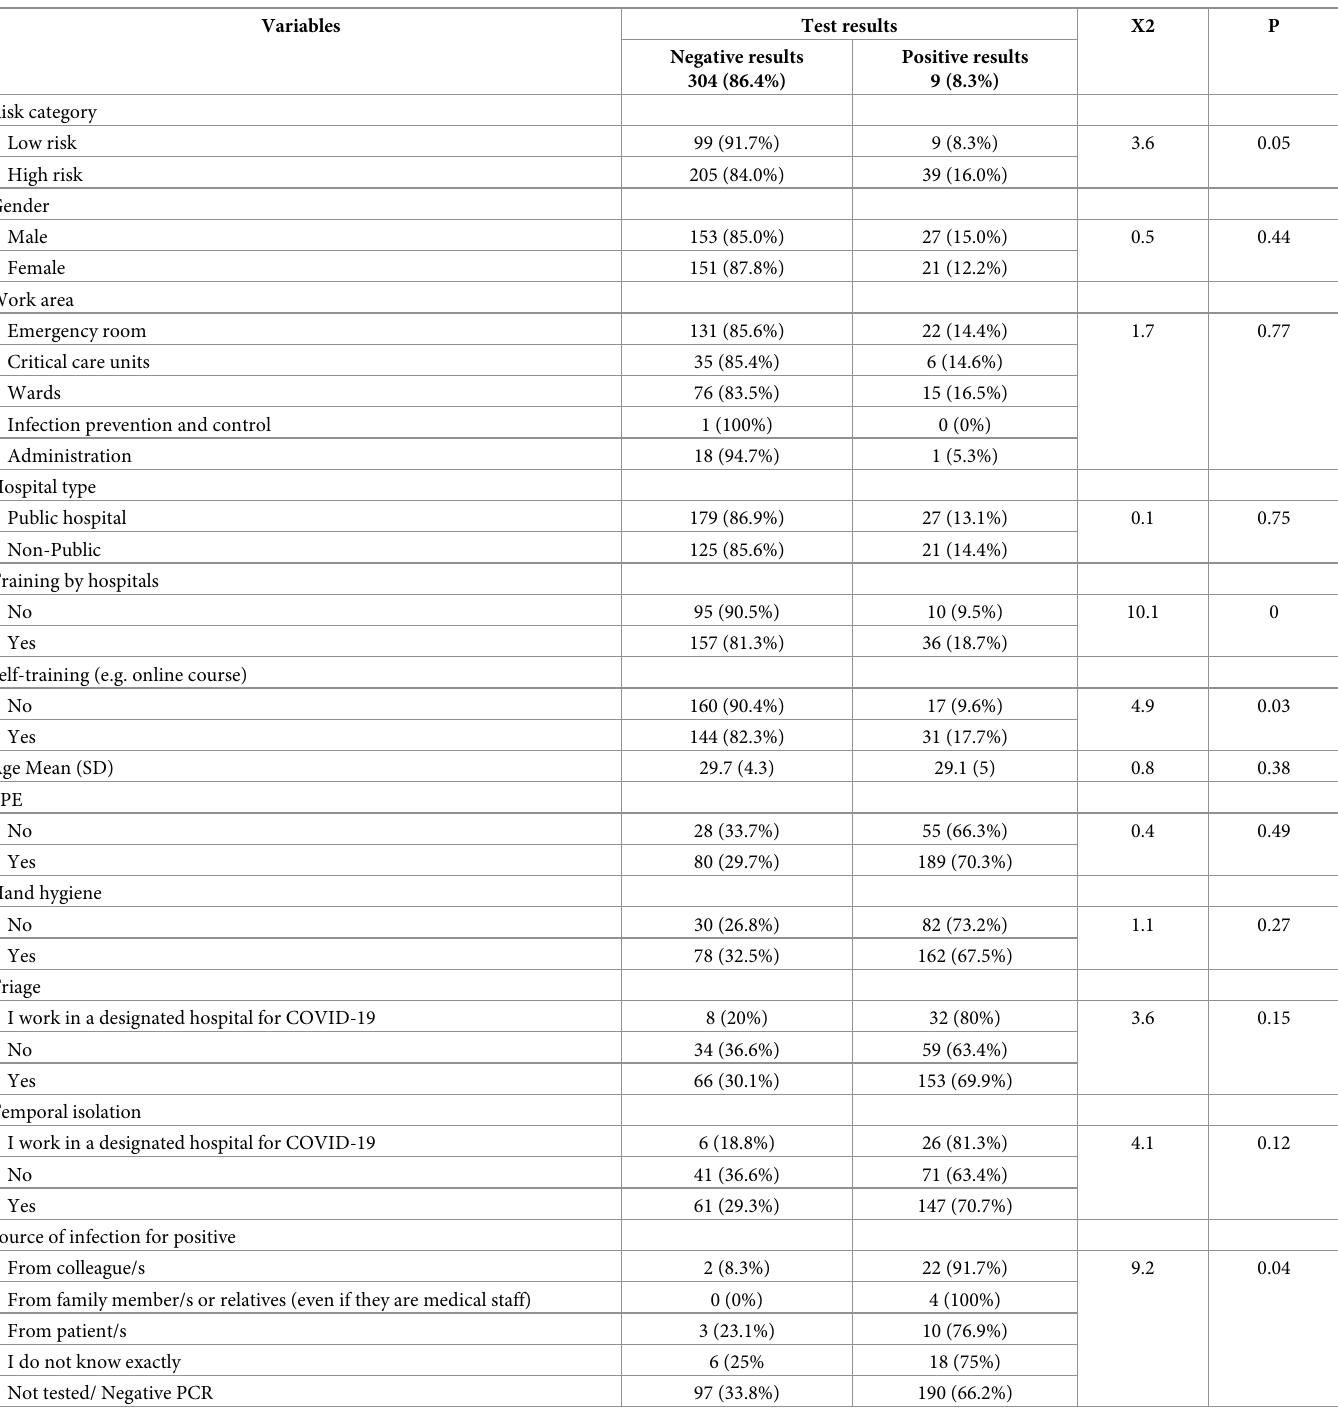
Table 5. Factors associated with confirmed COVID-19 infection among